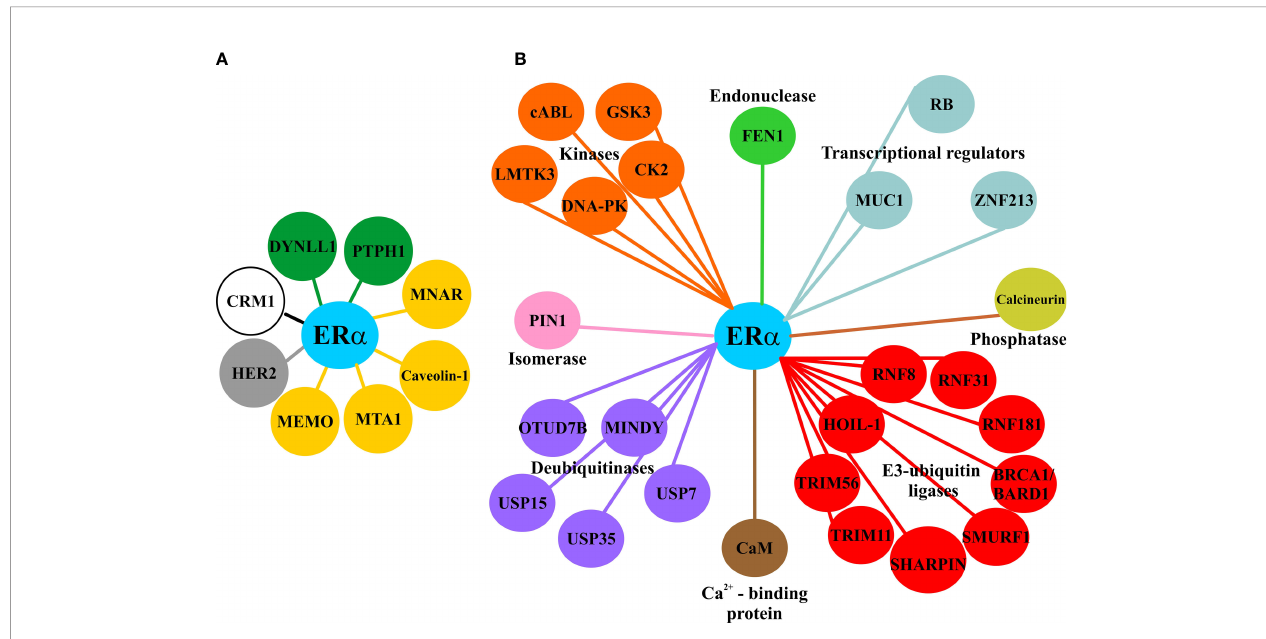
FIGURE 1 | Proteins related to subcellular transport of ER a and its stability in breast cancer cells. (A) Principal proteins involved in the nuclear accumulation of ER a in the nucleus (green), in the extranuclear localization of ER a (yellow), required for the nuclear export (white), and correlated with the nuclear translocation of ER a (gray). (B) Interactome of proteins that increase the stability of ER a in breast cancer